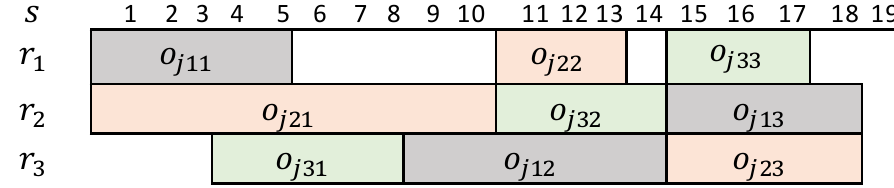
Figure 2. Schedule